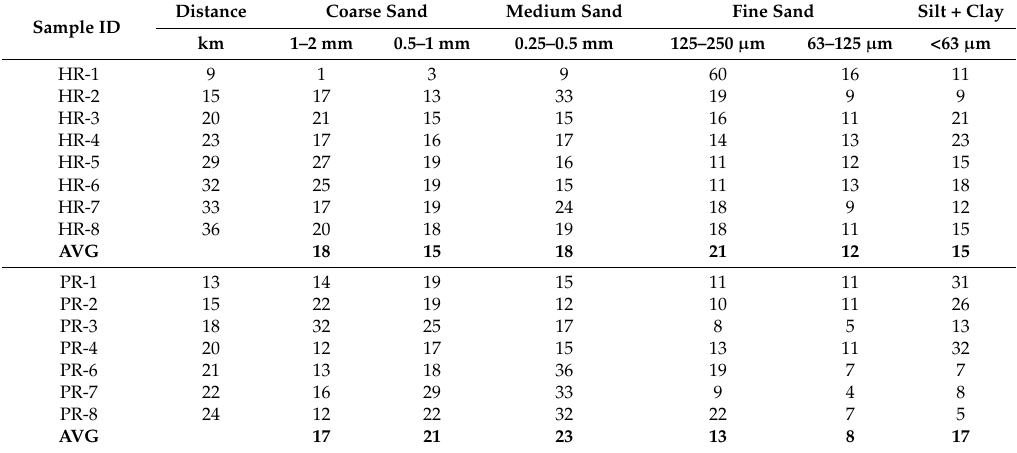
Table 4. Grain size distribution (wt %) for sediments (<2 mm grain size) collected from the Hackensack River (HR) and the Passaic River (PR) in summer 2015. Distance (km) indicates the distance from NB-6 located near the mouth of the Newark Bay.